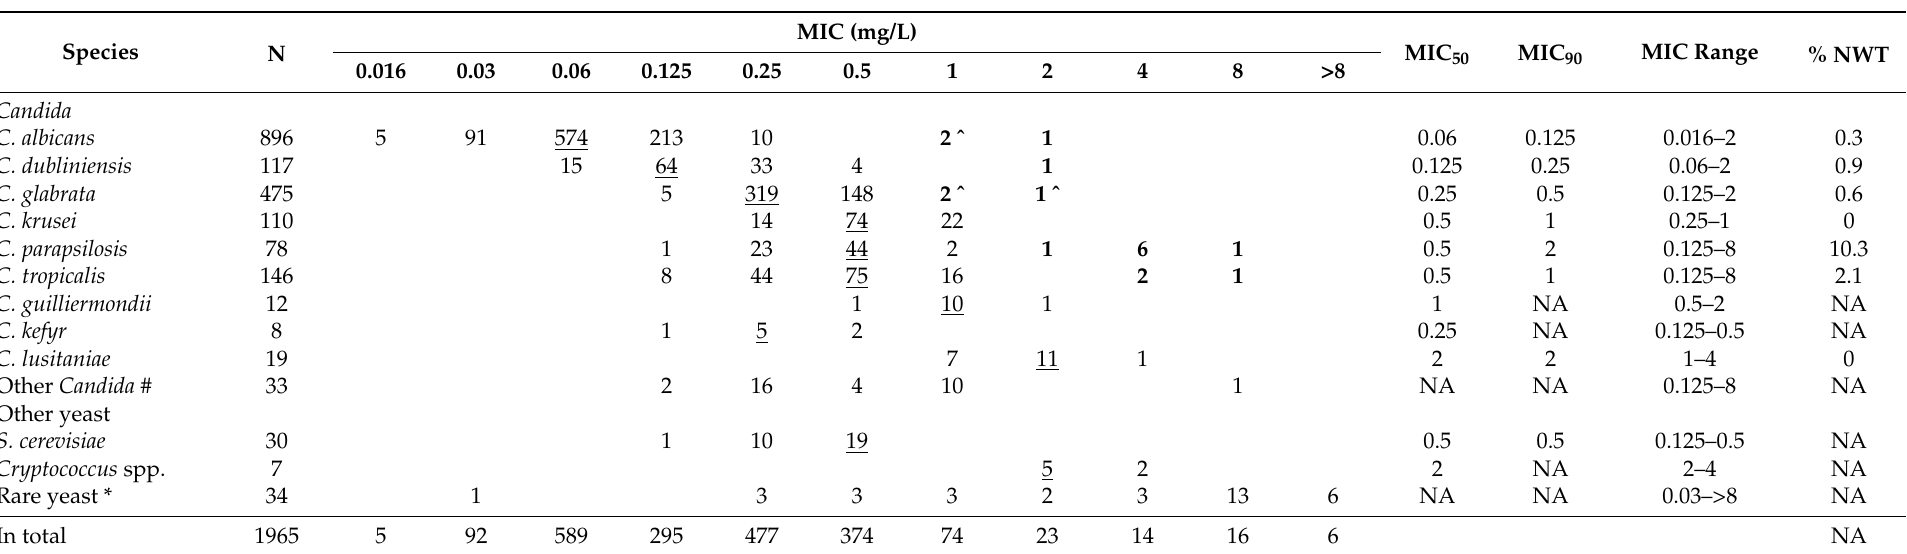
Table 1. Ibrexafungerp MICs (mg/L) for 1965 yeast isolates (incl. 1893 Candida spp. isolates) and three other species isolates from Denmark collected in 2020 and 2021